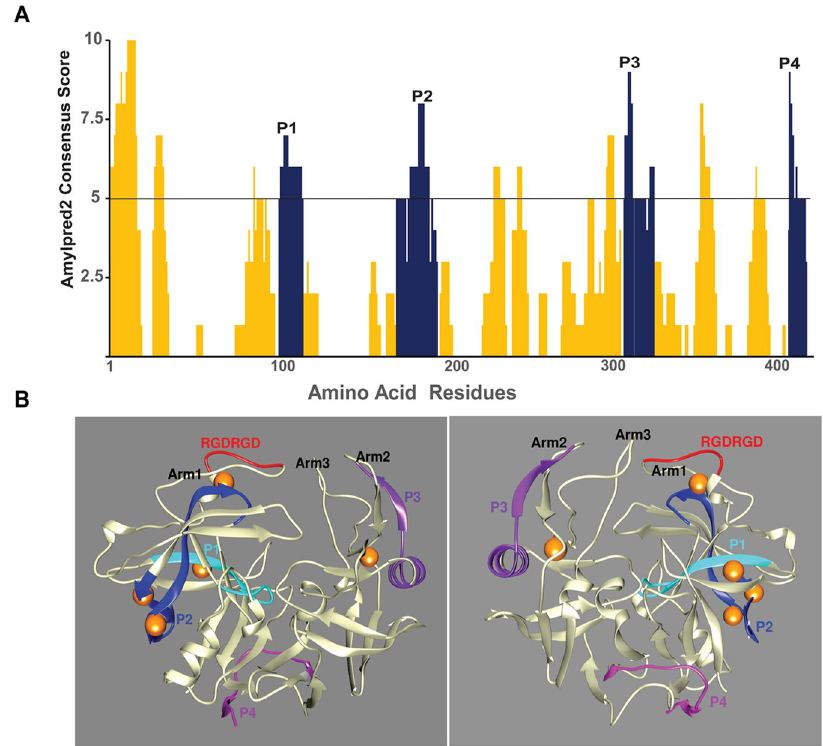
Figure 2. Sap6 contains amyloidogenic regions and zinc binding sites. ( A ) Sap6 primary structure is plotted with the likelihood of amyloidogenic structures using AmylPred2 prediction algorithms. Regions in which more than 5 out of 11 algorithms predict amyloid structure are shown in blue color bars and are designated as P1 (K 102 LSVIVDTGSS 112 ), P2 (Q 172 DTVGIGGASVKNQLFANVWSTSA 195 ), P3 (A 307 RSIIYALGGQVHFD 321 ), and P4 (A 404 QVKYTSESNIVAIN 416 ). ( B ) A three-dimensional model of Sap6 was constructed using Phyre2 software. Zinc binding sites were predicted using both amino acid sequence and three-dimensional structure of Sap6 using Ioncom server and Metal Ion-Binding (MIB) server 47, 48 . All predicted amyloid regions (P1 turquoise, P2 blue, P3 purple, P4 magenta) contain at least one beta strand and are surface localized. Two zinc- binding sites were found in the P2 region (zinc is shown with gold spheres); and a third predicted site is within the P1 region, while two other zinc-binding sites lie within non-amyloid regions. The surface-localized RGD binding domain (red) lies adjacent to the P2 region as well as a zinc-binding site within arm